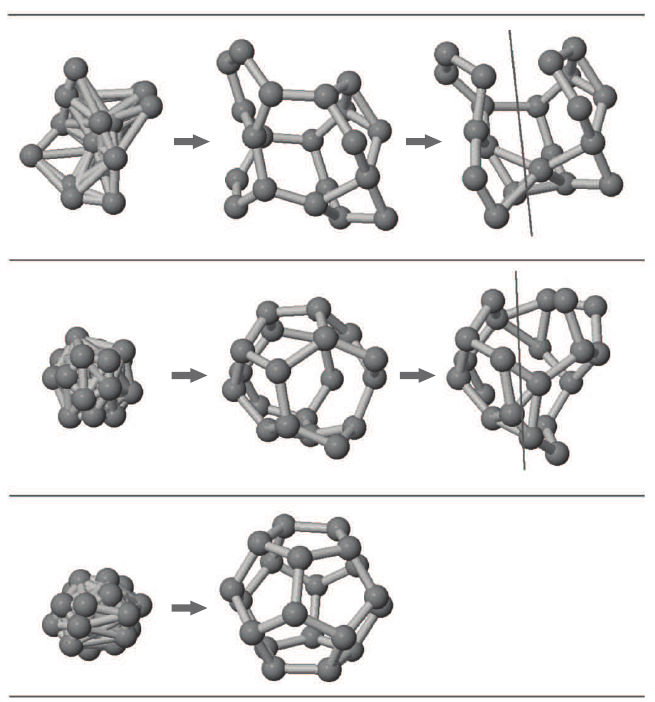
Figure 3. Illustration of the single parent GA implementation showing evolution of the fittest individual in C optimization. Three GA step samples are shown in separate lines ignoring 20 some intermediate GA steps. 1. Column shows the cluster just after the shrinkage mutation operation (initial geometry in top line), 2. Column shows the result of local optimization and 3. Column shows the cluster after the piece rotation mutation step together with the cutting